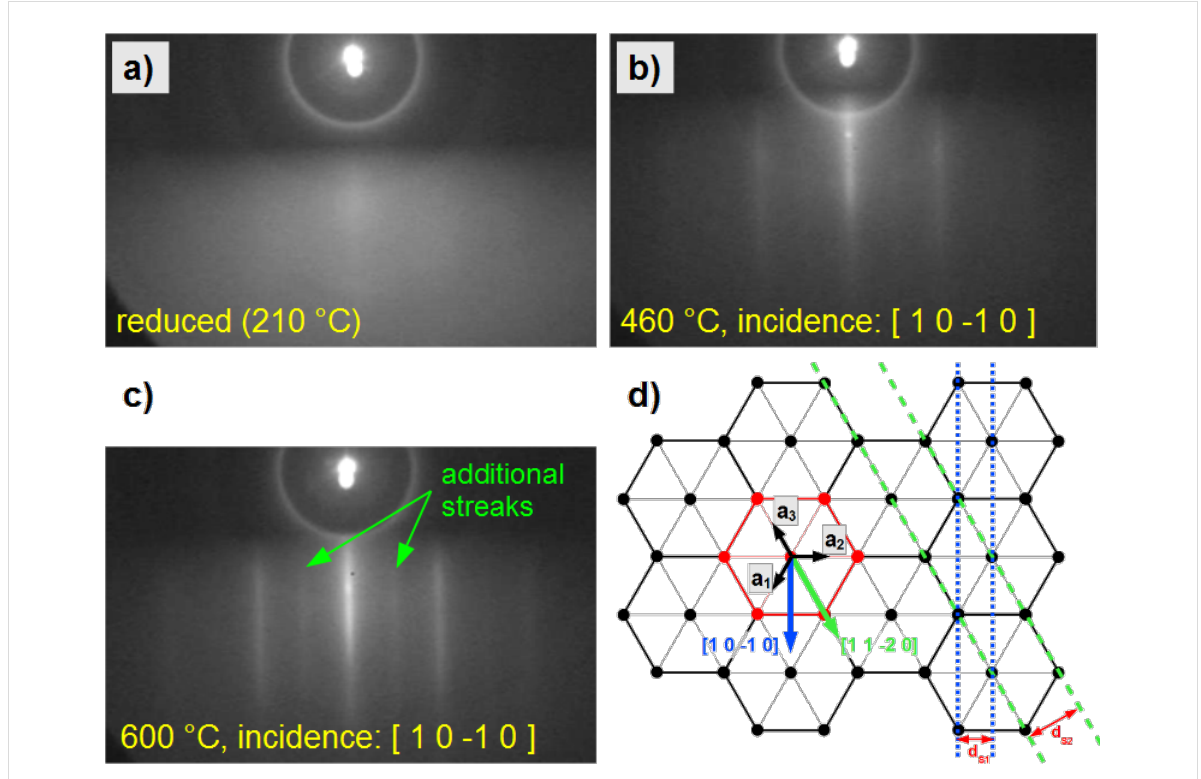
Figure 5: (a–c) RHEED patterns of a FePt film on Al 2 O 3 (0001), recorded with an electron beam energy of 25 keV after different annealing steps at a) 210 °C reduced in hydrogen plasma for 30 min, b) annealed at 460 °C for 30 min, and c) annealed at 600 °C for 45 min. The bright streaks in panel b) and c) indicate highly (111)-textured domains of the cubic A1 phase while the additional weak streaks in c) can be assigned to an additional frac- tion of the L1 0 phase with (101)-textured domains. Panel d) illustrates the hexagonal in-plane symmetry of the substrate and the directions of the inci- dent